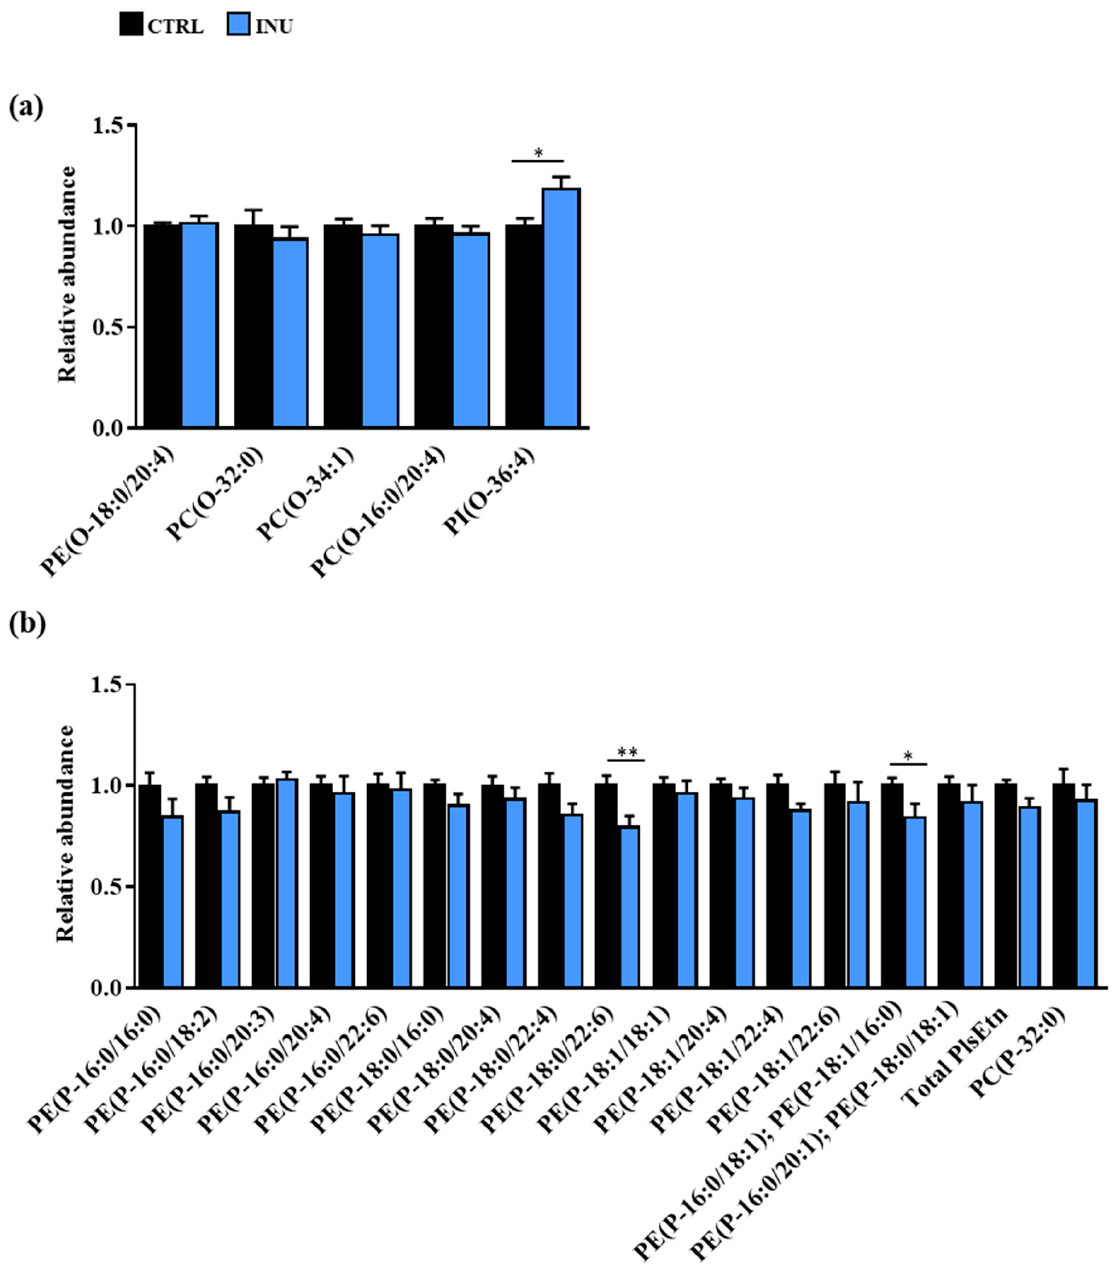
Figure 3. Changes in the abundance of AKG and Pl species in the cortex of mice fed a diet sup- plemented with inulin. ( a ) AKGs and ( b ) Pls. Results are expressed as fold change in the cortex of INU mice relative to the mean level observed in the cortex of CTRL mice, defined as 1.0. All data are presented as mean ± SEM. Mann–Whitney test for comparison of each AKG or Pl species abundance between CTRL and INU mice, * p < 0.05, ** p < 0.01. AKG, alkyl-glycerophospholipid; PI, Plasmalogen; SEM, standard error of the